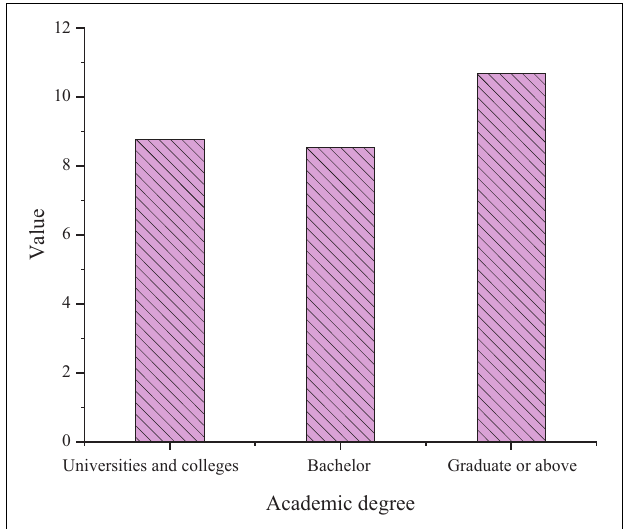
FIGURE 6 | Average PsyCap scores of college entrepreneurs with different educational backgrounds.